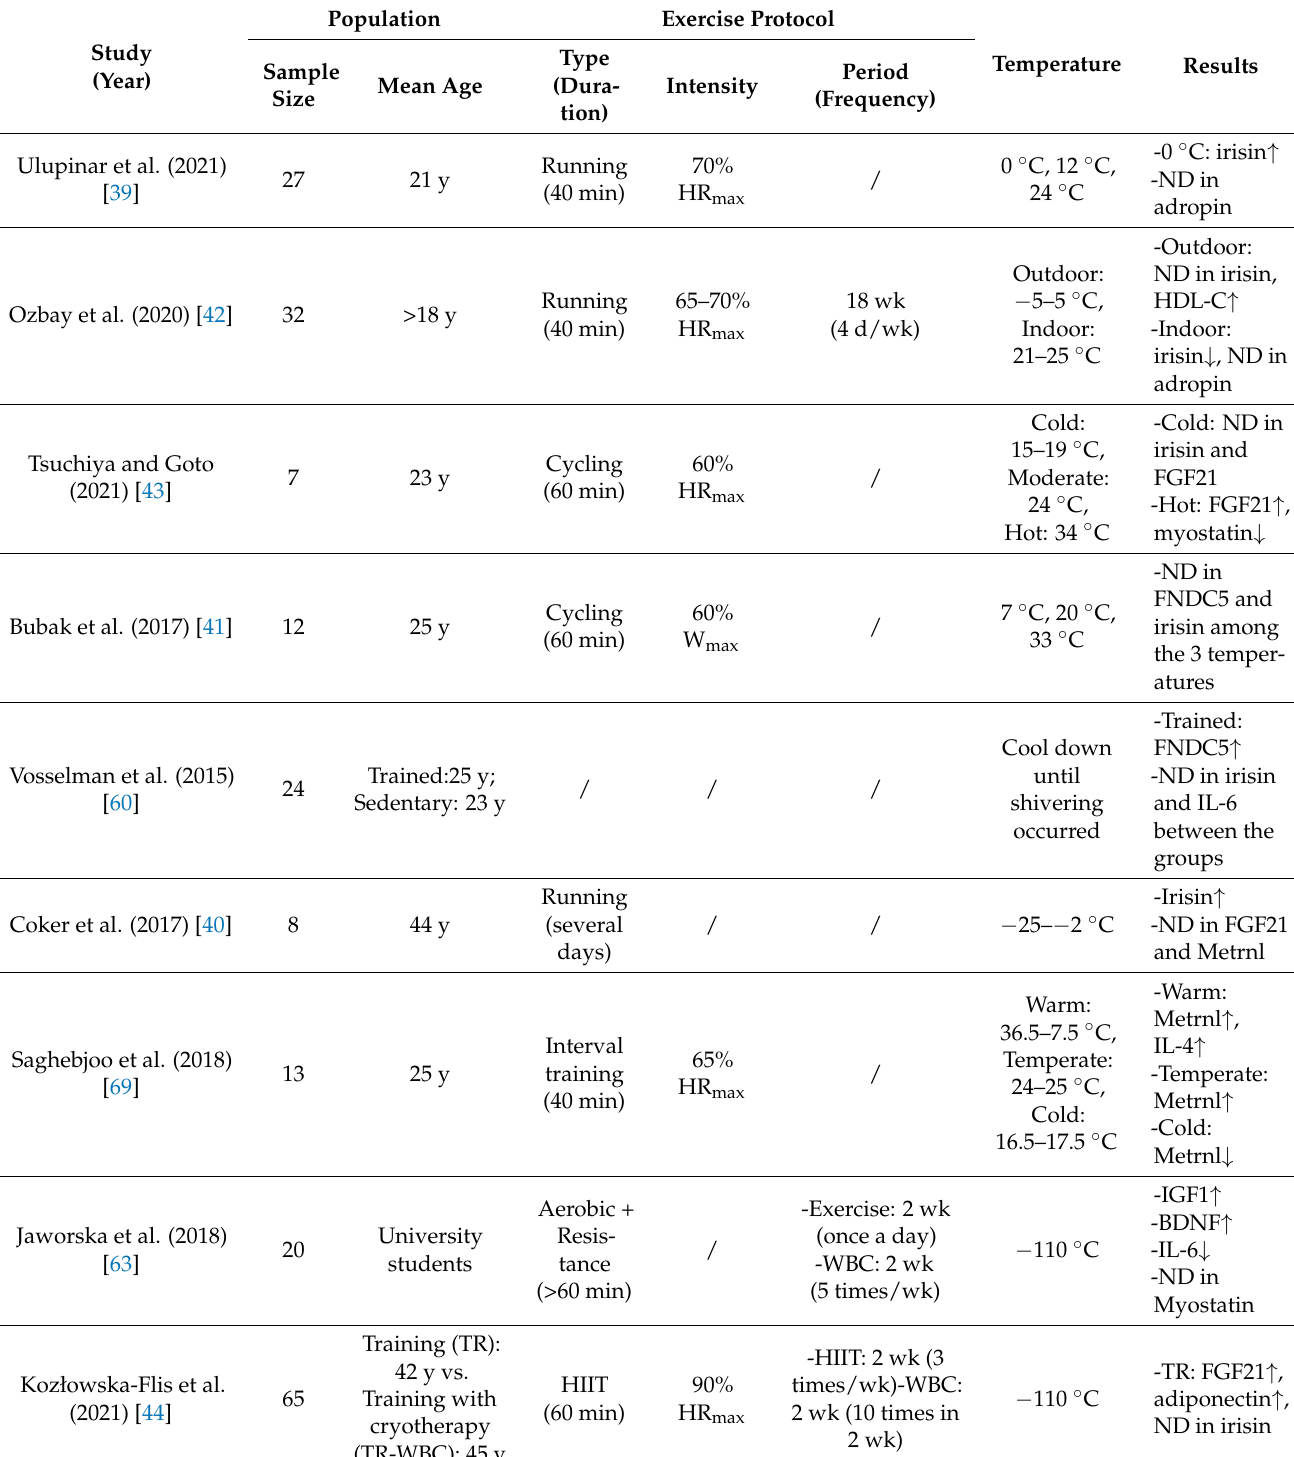
Table 2. Human studies examining myokine secretion following exercise and cold